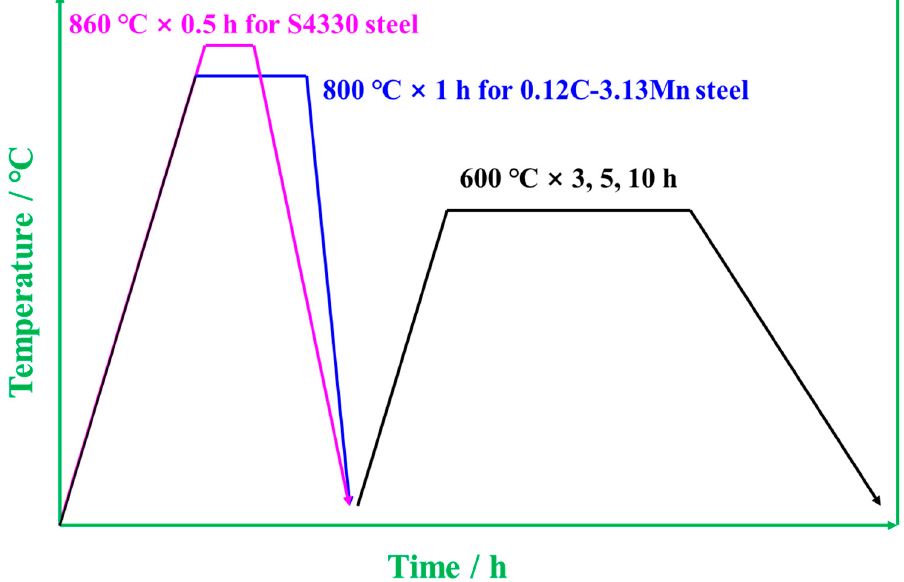
Figure 1. Schematic diagram for 0.12C-3.13Mn steel and S4330 steel. Mechanical Property Tests: The round tensile samples, with a gauge length of 50 mm according to the standard of GB/T228.1-2010, were performed at a crosshead speed of 1 mm/min using a WE-300 hydraulic tensile testing machine (Jinan Chenxin testing ma- chine Manufacturing Co., LTD., Jinan, China). The Charpy V-notch samples were machined according to the GB/T229-2007, which was performed using a JBN-300B impact machine at ± 40 ◦ C. The standard FCGR samples were machined following the GB/T 6398-2017. The sample thickness (B) was 12.5 mm, and the length and width were 62 mm.